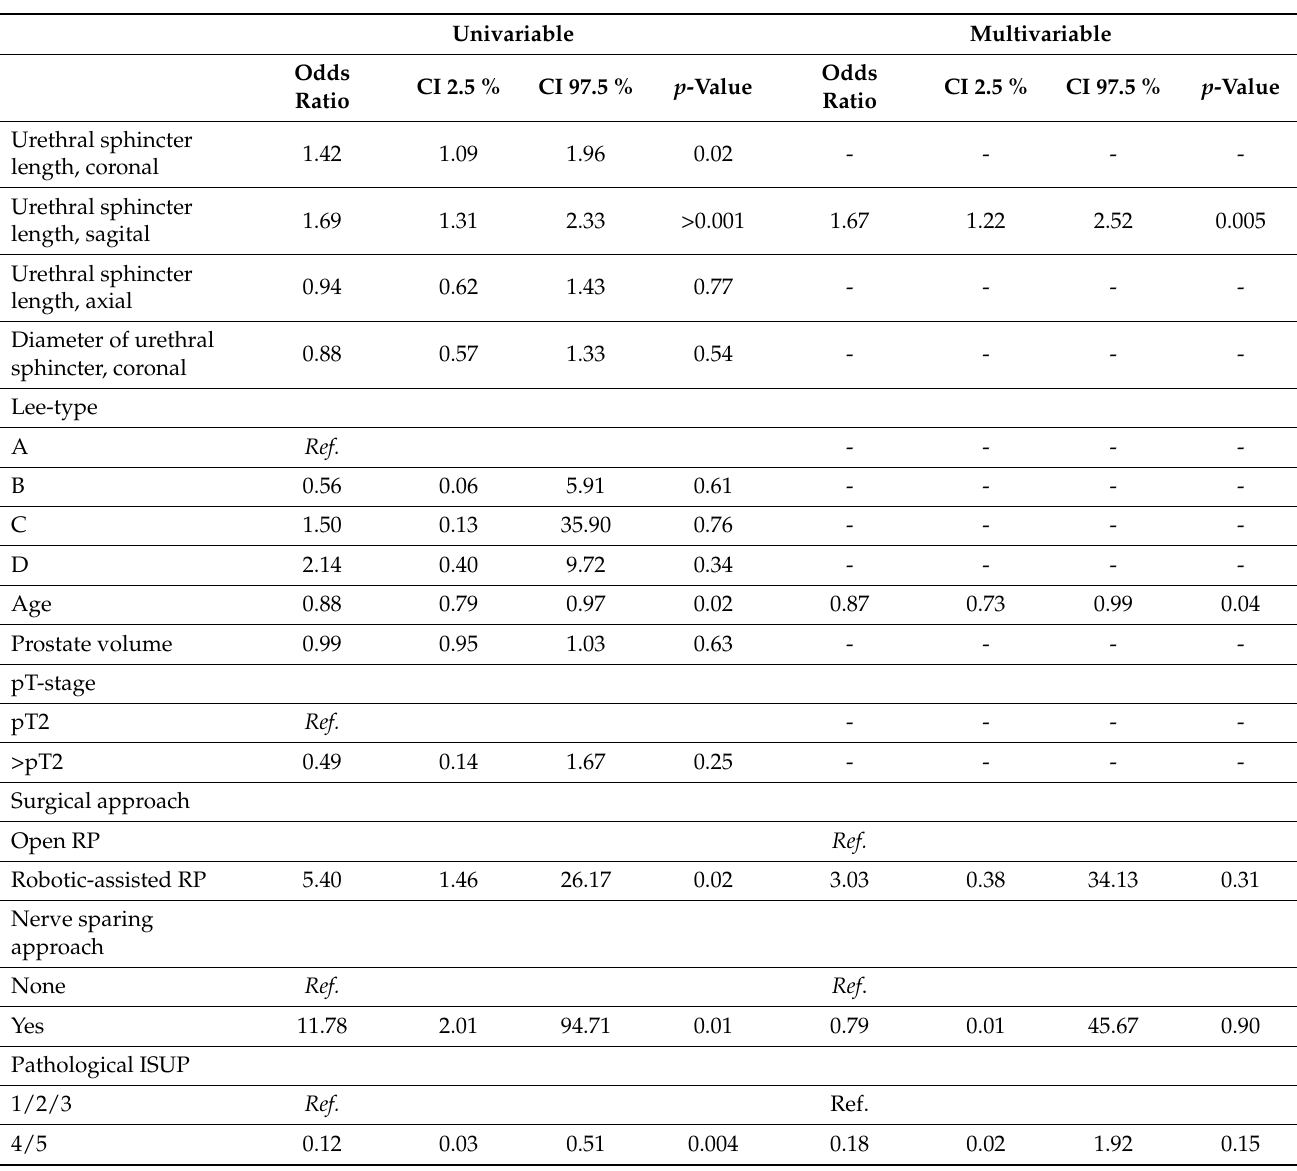
Table 3. Univariable and multivariable logistic regression models predicting urinary continence at medium follow-up following radical prostatectomy, defined as none or one safety pad per 24